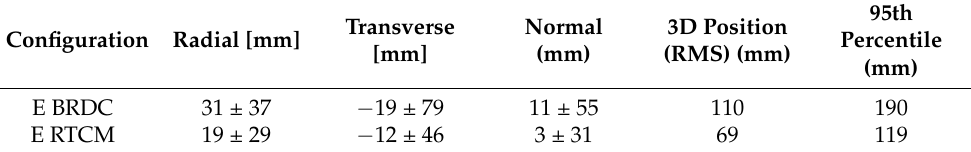
Table 3. Position difference statistics for 24–30 September 2021. For each configuration, the difference is computed with respect to the CNES-POD solution. For the individual axes (RTN frame), the mean values ± standard deviation of the differences are provided. The 95th percentiles are calculated for the position (3D) differences. The filter transient is not